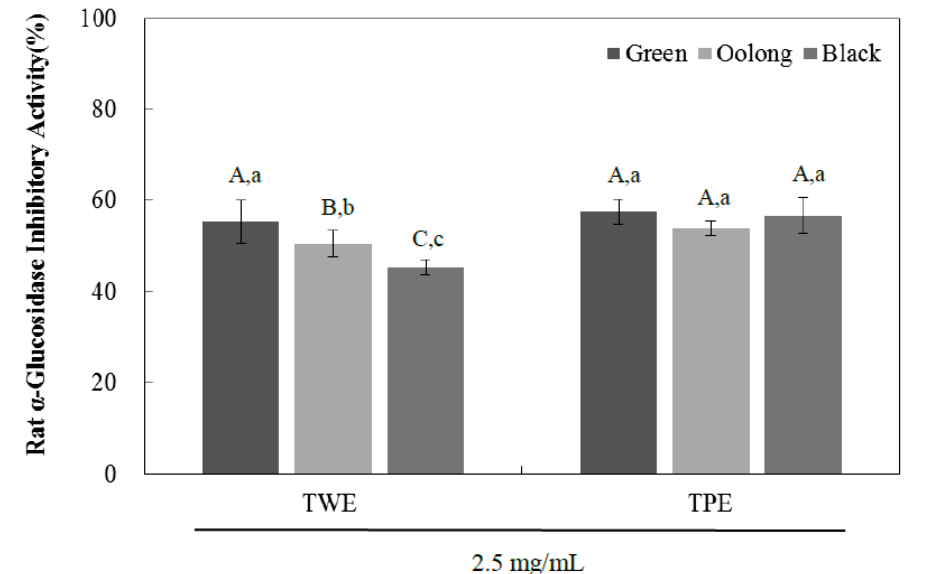
Figure 1. The inhibitory effects of tea water extract (TWE) and tea pomace extract (TPE) of green, oolong, and black tea at a concentration of 2.5 mg/mL on rat small intestinal α -glucosidase activity. The α -glucosidase activity was determined by measuring p -nitrophenol released from pNPG at 404 nm. Results are expressed as mean ± SD from three independent experiments in triplicate. Different corresponding letters indicate significant differences at p < 0.05 by Duncan’s test. A − C The first letters in uppercase are different among the types of tea within same extraction method and a − c the second letters in lower-case indicate significant differences between TWE and TPE